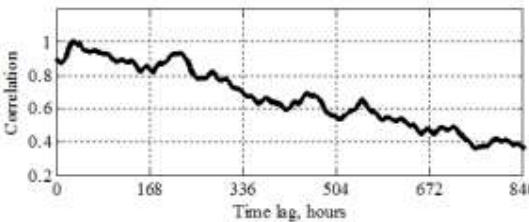
Figure 14. The cross correlation of wind speed and wind power time